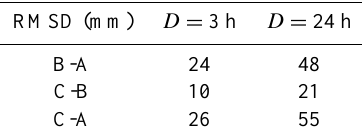
Table 1. Root-mean-square differences (mm) of rainfall depth thresholds estimated at the 69 sites composing the “old” dataset, with the three schemes. A: old method, old dataset; B: new method, old dataset; C: new method, new extended dataset (but only esti- mates at the 69 sites are considered for this